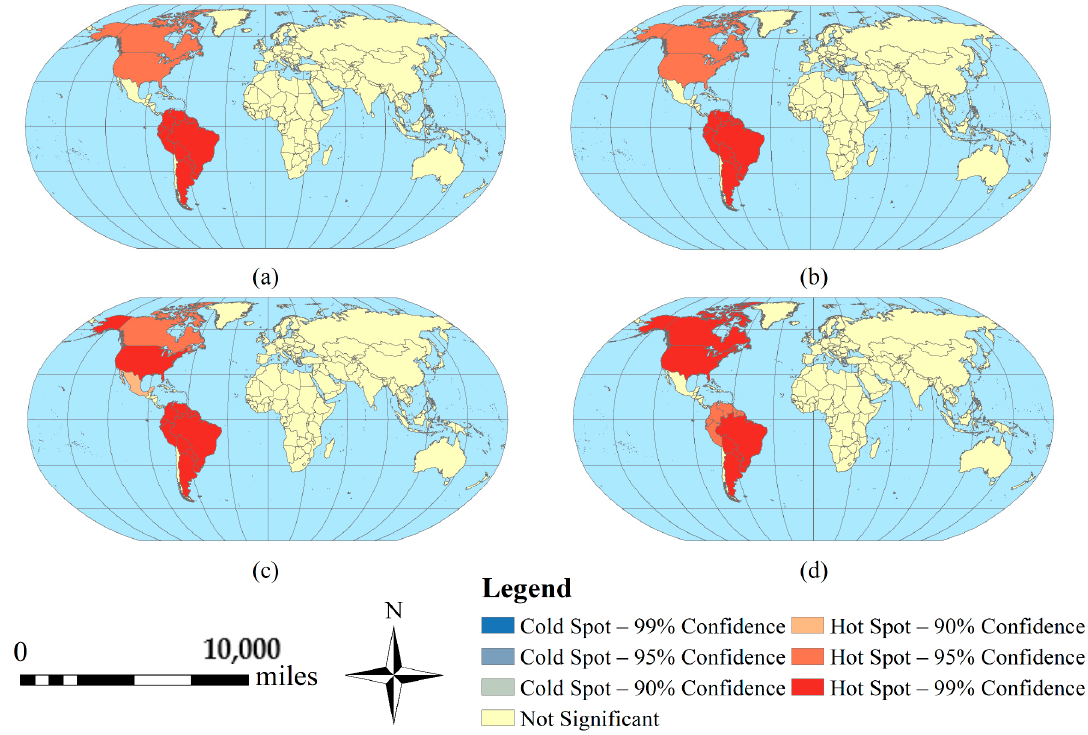
Figure 5. Hot spots of ZIKV epidemic. The sub-graph ( a – d ) represent 2015, 2016, 2017 and 2018 respectively.